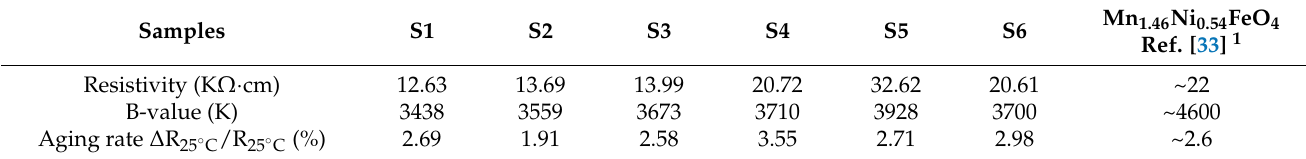
Table 3. The resistivity, B-values and aging rates of the sintered